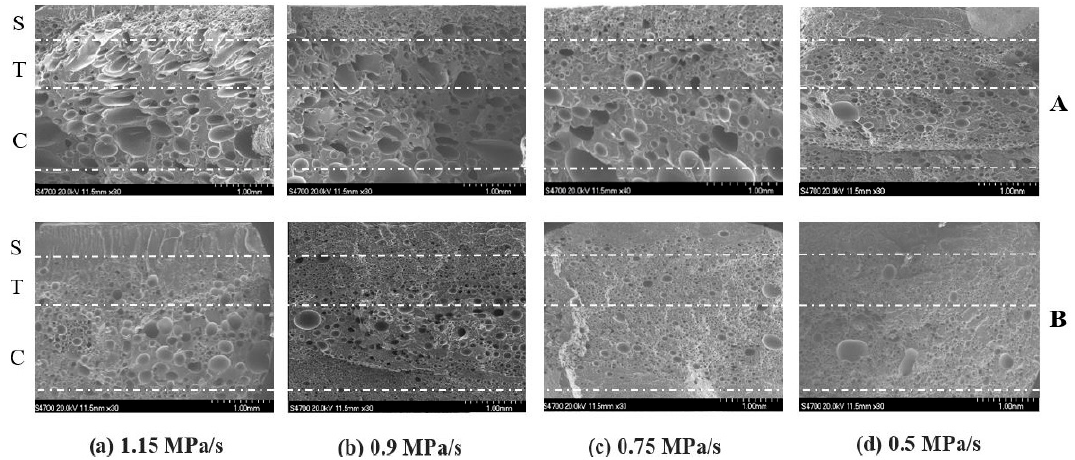
Figure 19. Representative SEM micrographs of the injected foams of pure PLA ( a ) and PLA/nanoclays ( b ) with four different dropping pressure speeds (1.15, 0.9, 0.75, and 0.5 MPa/s). Reprinted from Xie et al. [136].